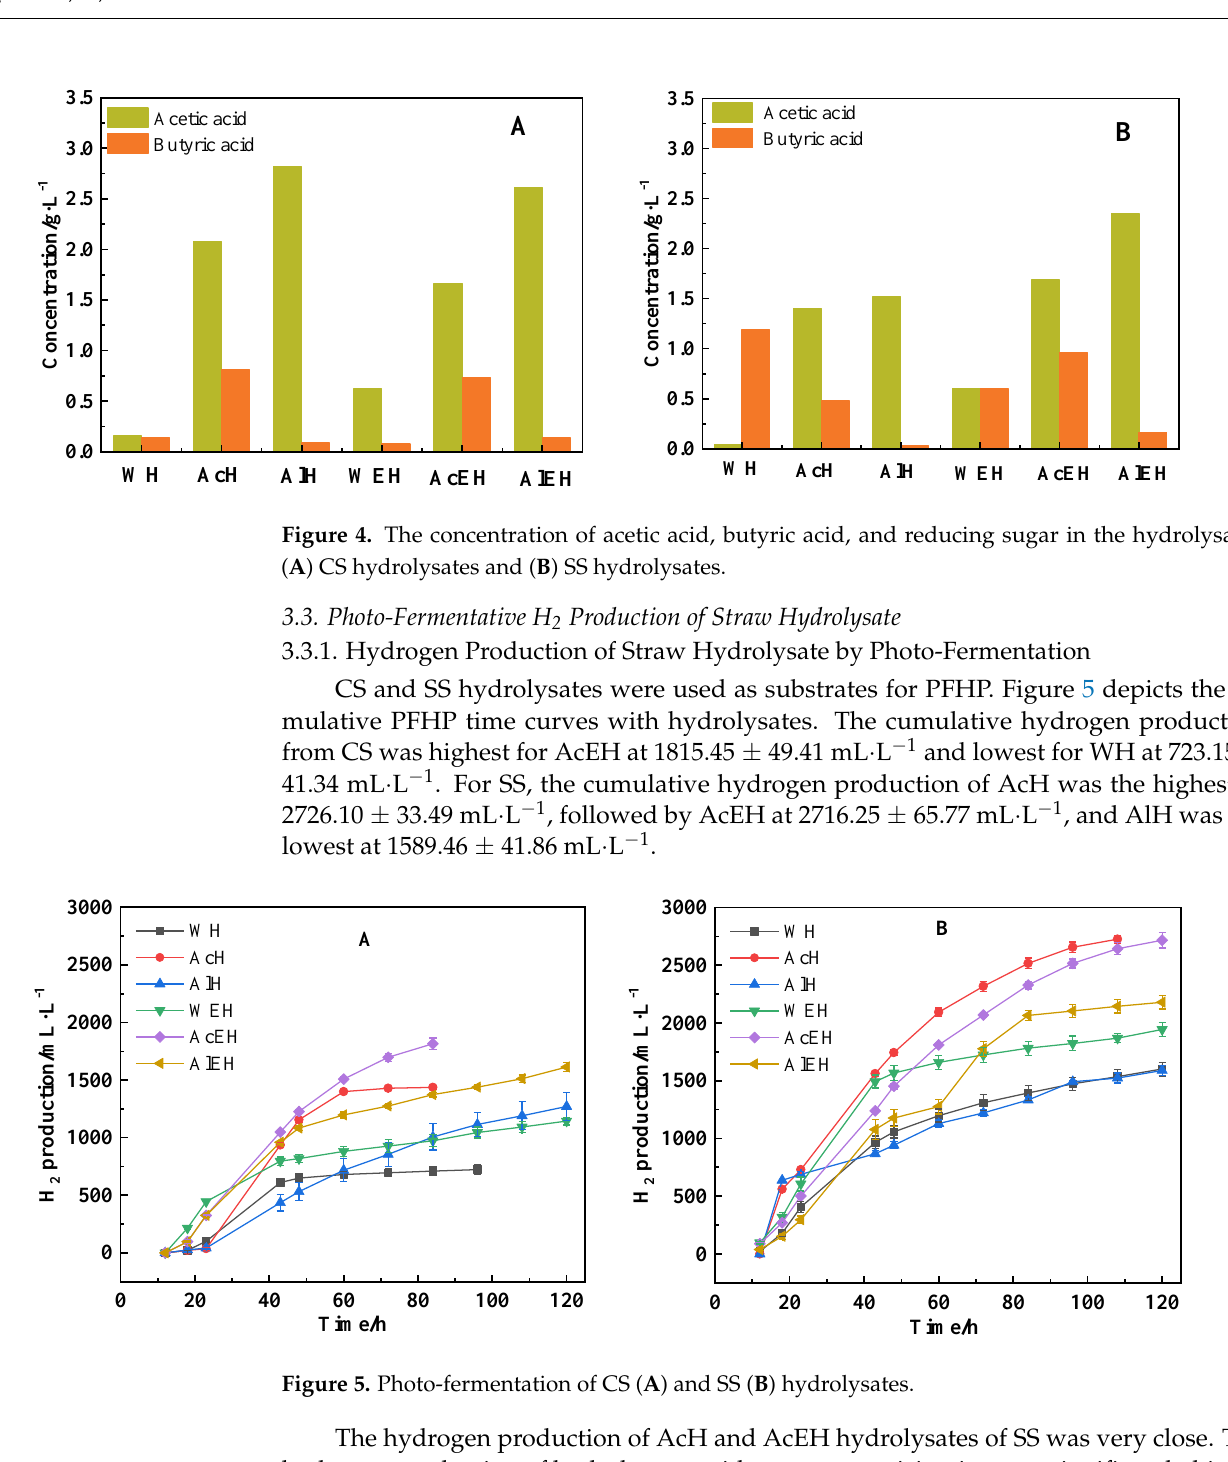
Figure 5. Photo-fermentation of CS ( A ) and SS ( B ) hydrolysates. The hydrogen production of AcH and AcEH hydrolysates of SS was very close. The hydrogen production of hydrolysates with enzyme participation was significantly higher than the corresponding hydrolysates without enzyme participation. WEH, AcEH, and AlEH of CS produced 58.25%, 26.32%, and 26.97% more hydrogen than WH, AcH, and AlH, respectively. WEH and AlEH of SS produced 21.42% and 37.19% more hydrogen than WH and AlH, respectively. The hydrolysates performed better due to more substances conducive to photo-fermentation in the hydrolysate with the participation of enzymes. Hydrogen production of AcH and AcEH hydrolysate was high due to the high content of reducing sugar. AlH hydrolysate has a lower reducing sugar content, a higher organic acid content, and a darker color with a higher shading effect, resulting in lower hydrogen